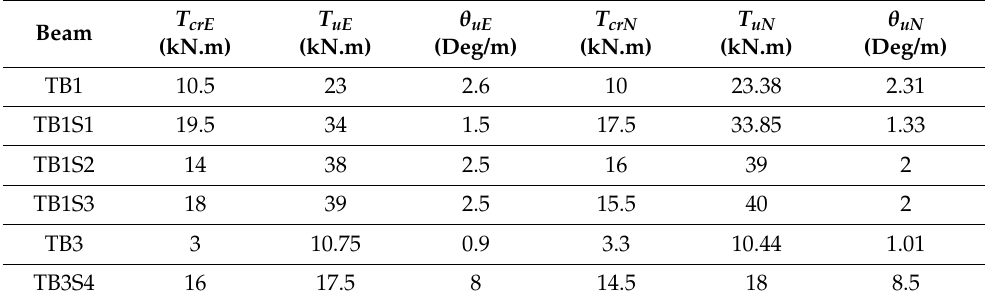
Table 4. Cracking torque, ultimate torque, and maximum angle of twist for the beams TB1, TB1S1,